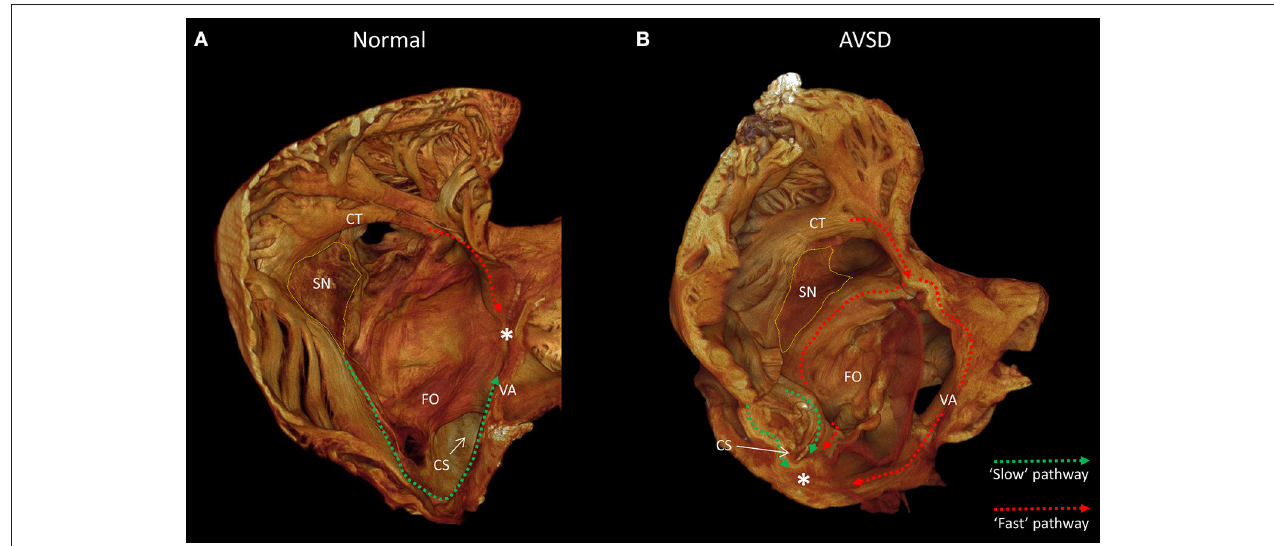
FIGURE 1 | The anatomy of the slow and fast pathways in the right atrium. (A) indicates the anatomical locations of the slow pathway (green), fast pathway (red), and compact atrioventricular node (*) in the normal heart, viewed from inferior-lateral position. (B) indicates the hypothesized anatomical location of the slow pathway (green) and fast pathway (red) in a heart with a atrioventricular septal defect, note the compact atrioventricular node (*) is displaced posterior-inferiorly. Images derived from micro-CT data. *Location of compact atrioventricular node; CS, coronary sinus; CT, terminal crest; FO, fossa ovale; SN, sinus node; VA, valve